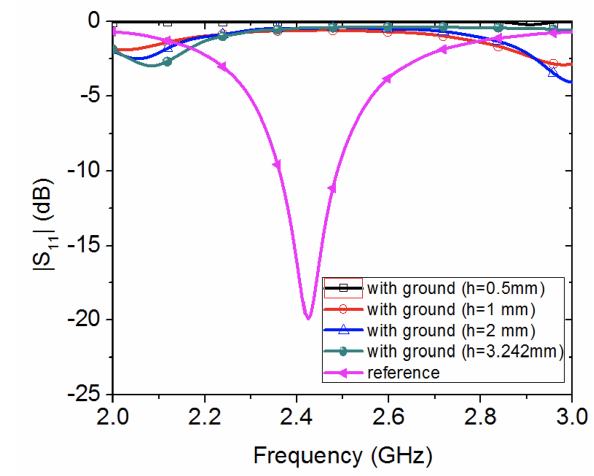
Figure 13. Numerical parametric study of the effect of thickness on grounded wearable loop antenna with cotton